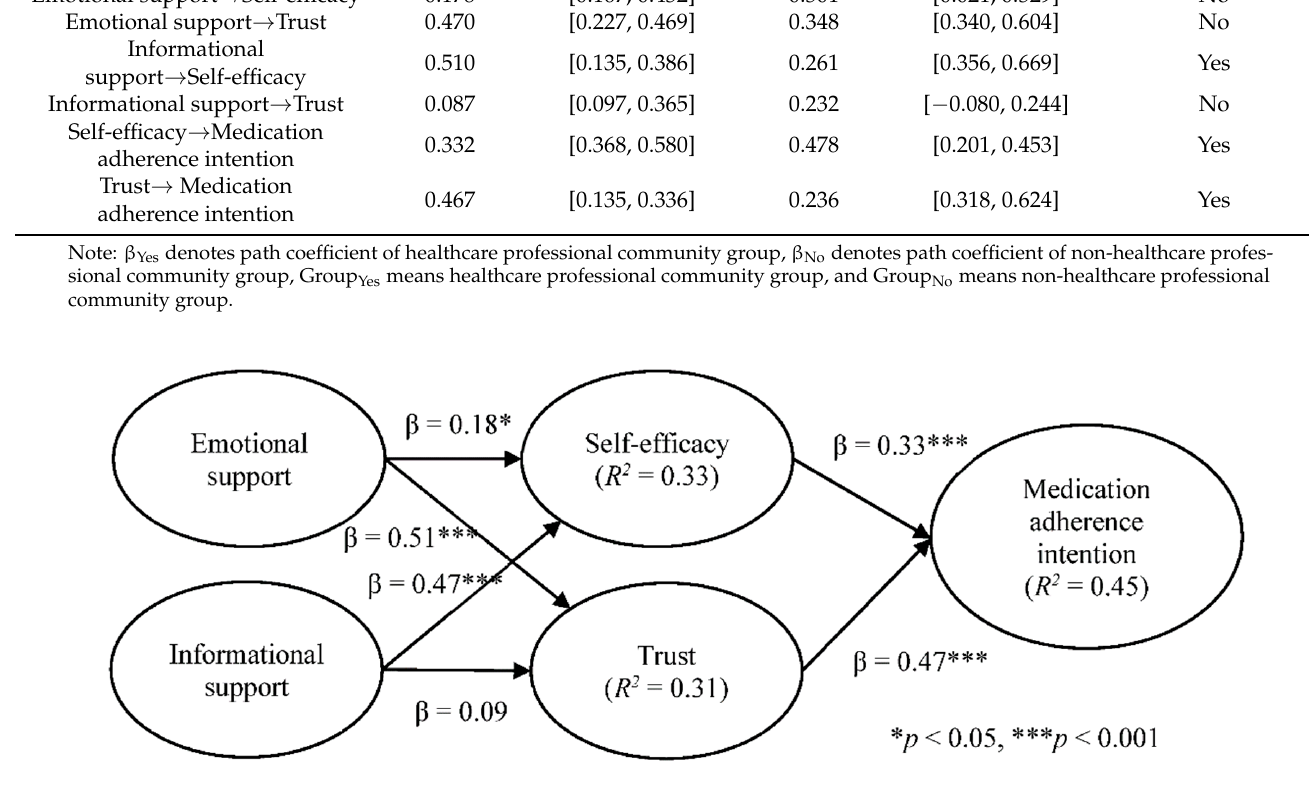
Table 4. Multi-group analysis of online community participation.